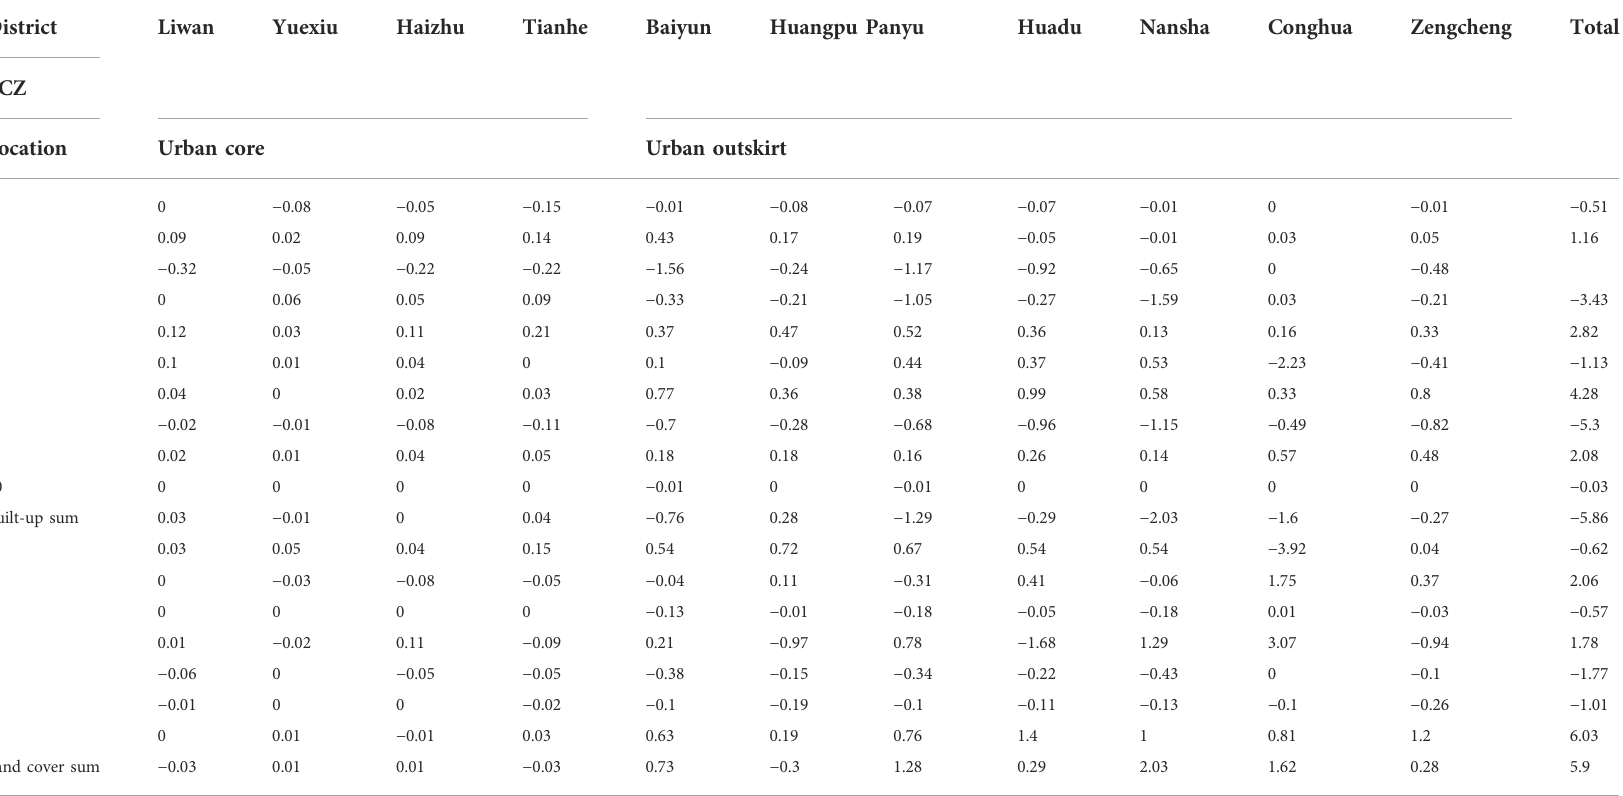
Table 5 shows the difference calculated by using a percentage of LCZs surface classi fi ed by GIS minus counterpart classi fi ed by RS. The darker the color shown by the cells of the table, the greater the divergence between results generated by GIS and RS